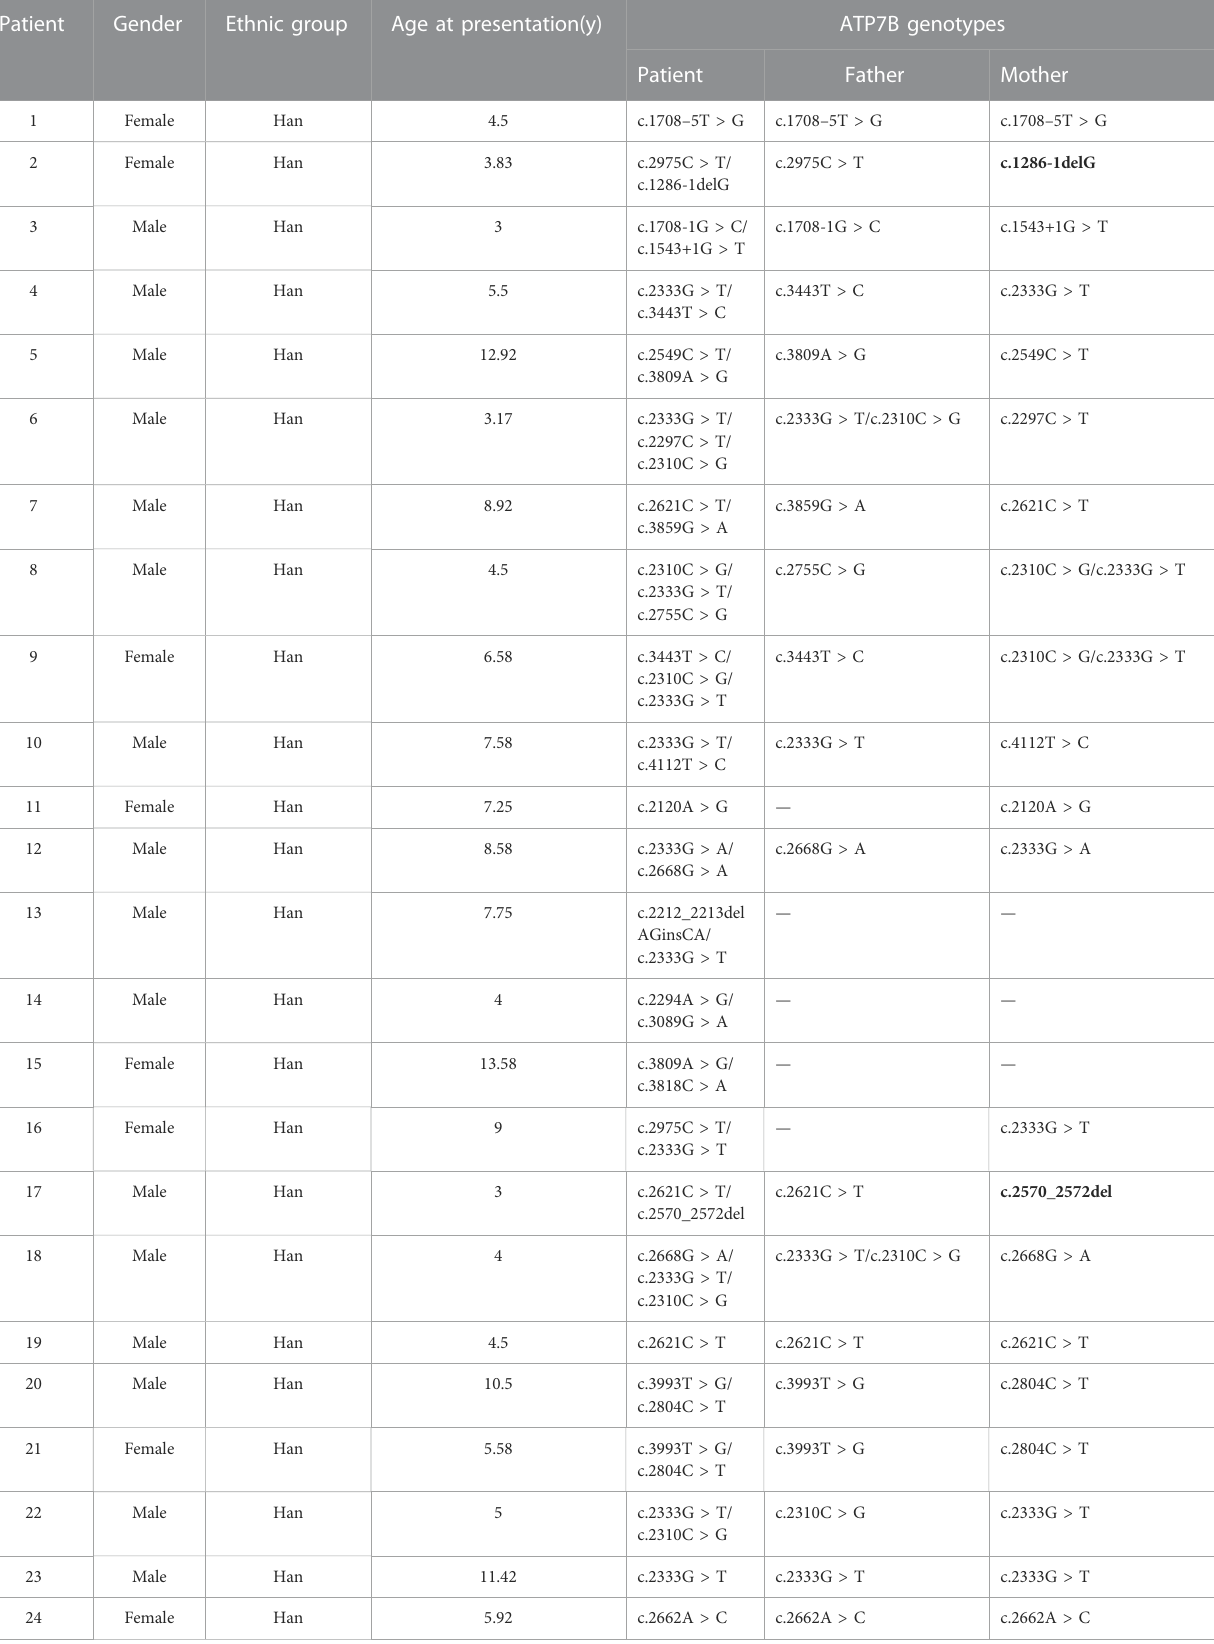
TABLE 2 Clinical and genetic data of the 39 patients with